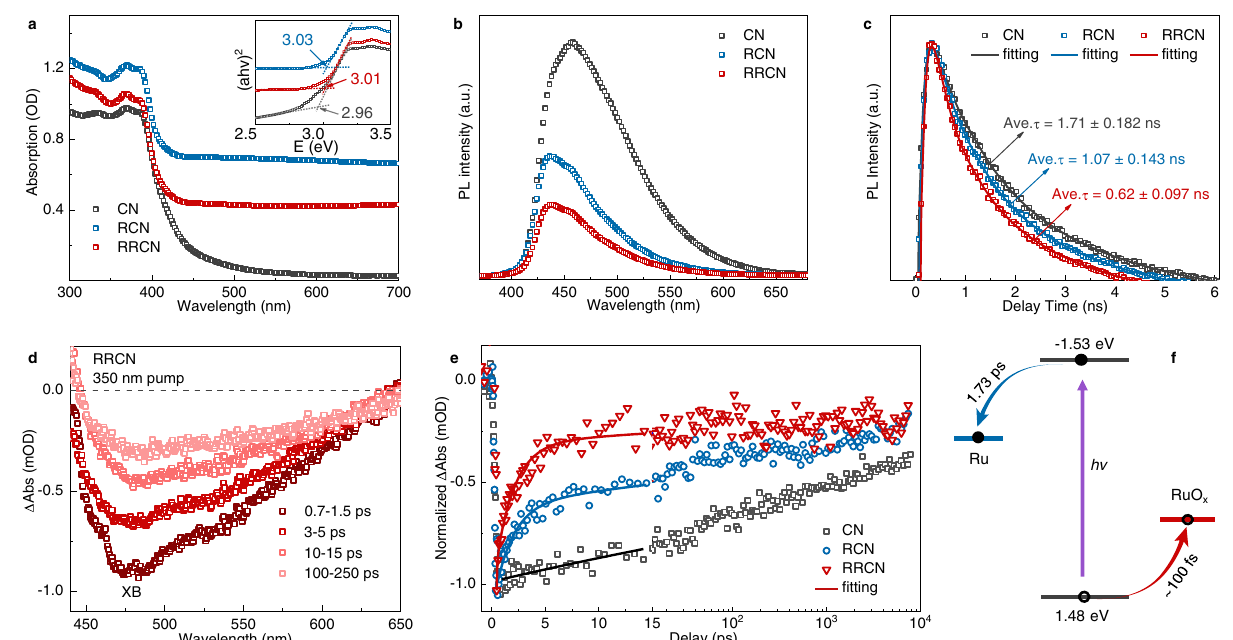
Fig. 4 | Optical and charge-transfer properties. a UV-vis diffuse re fl ectance spectroscopy of CN, RCN, and RRCN. Insert, Tauc plot of the diffuse re fl ectance data in ( a ). b Steady-state PL spectra at 298K. c Time-resolved PL kinetics at the corresponding steady-state emission peaks in ( c ) at 298K. d TA spectra of RRCN